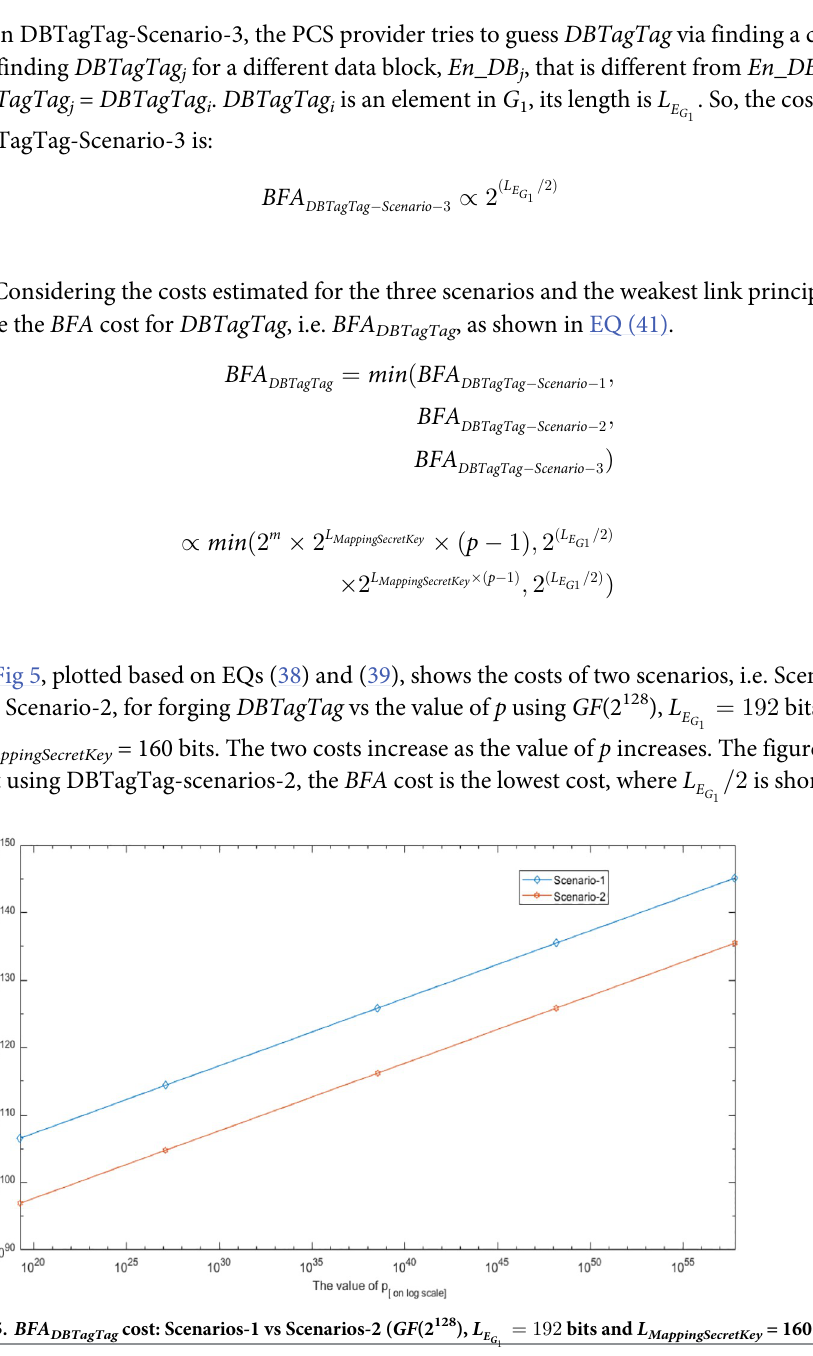
Fig 5. BFA DBTagTag cost: Scenarios-1 vs Scenarios-2 ( GF (2 128 ), L